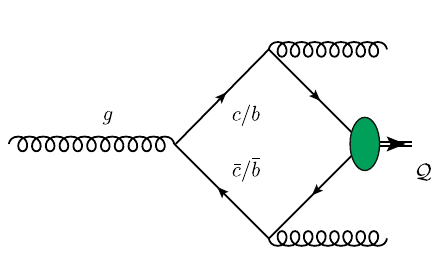
Fig. 1 Left: One of the leading diagrams contributing to the heavy- ( 1 ) vector quarkonium Q at order α 2 s . Right: quark fragmentation to a 3 S 1 One of the leading diagrams contributing to the gluon fragmentation